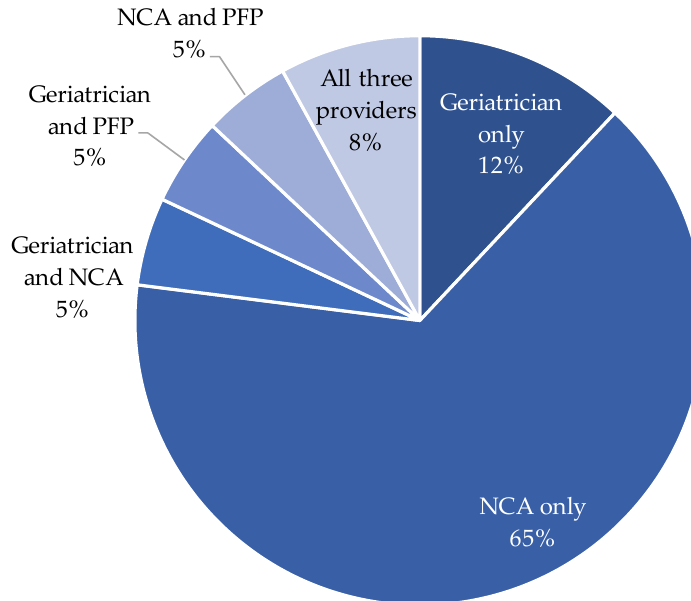
Figure 1. Percent of patients in the study sample seen by one or more providers.